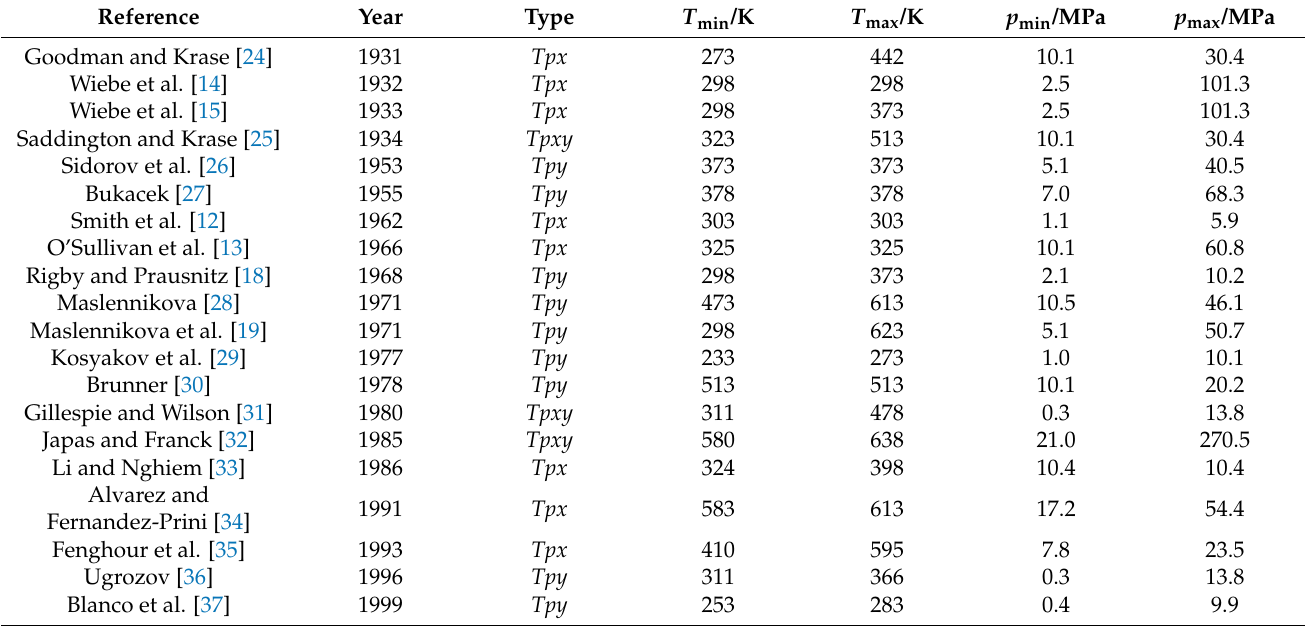
Table 1. Literature data of the (H 2 O + N 2 ) binary